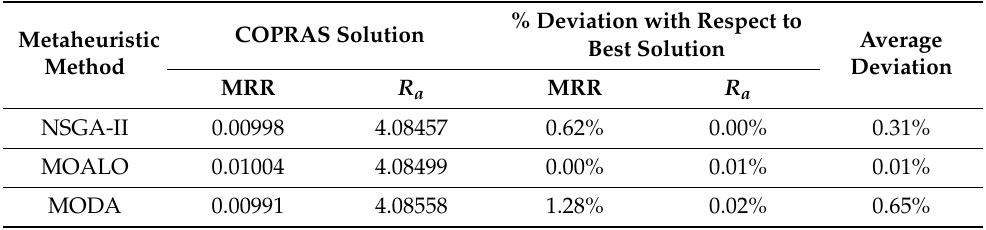
Table 7. Deviation in solutions of different metaheuristics as compared to the COPRAS best solution (Example 2, 800 µ m